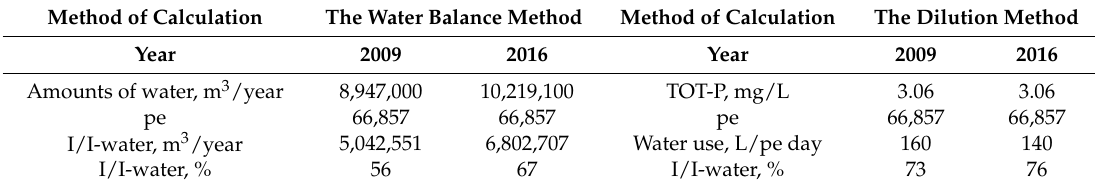
Figure 5. Discharge from the Solumstrand wastewater district for the years 2009–2016. Table 7. Calculated volumes of I/I water in Drammen with the water balance method and the dilution method for 2008 and 2016.